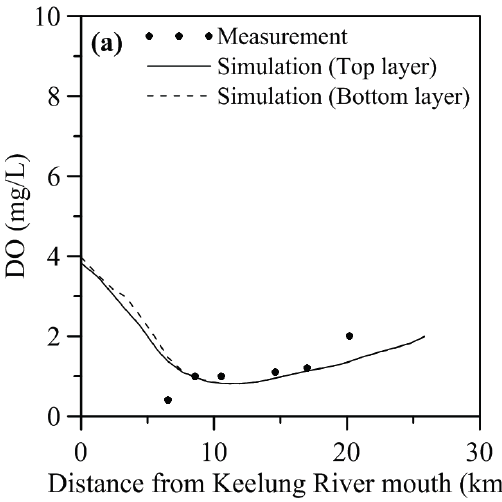
Figure 7. Comparison between measured and simulated water quality distribution along the Keelung River on 1 March 2010: ( a ) DO; ( b ) CBOD; ( c ) NH (simulated result shown only as no NO